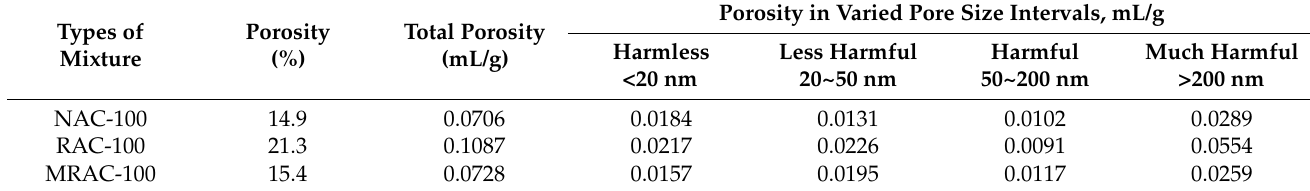
Figure 7. Pore size distribution of hardened pastes of the concrete at 28 days. Table 6. The porosity in varied pore size intervals for hardened pastes.